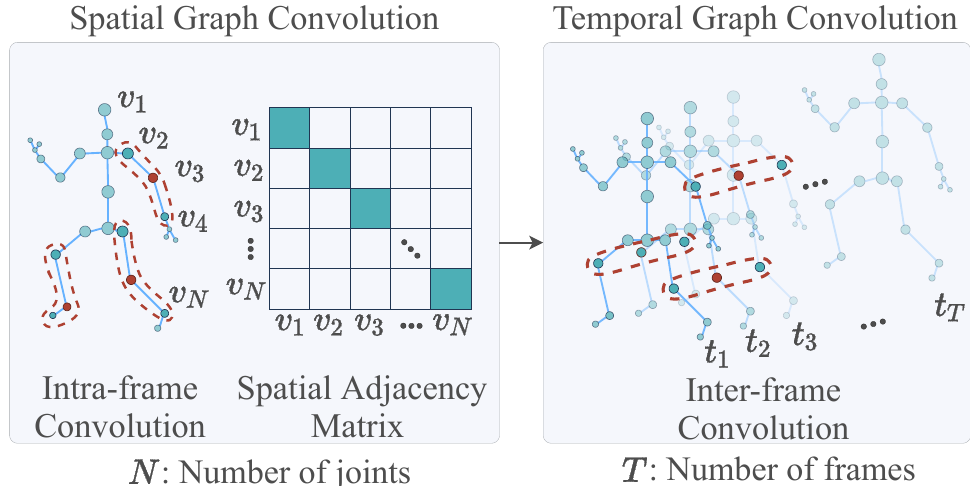
Figure 7. A spatiotemporal graph of a skeleton sequence. Light green dots represent the body joints (graph nodes). Light blue edges illustrate the intra-body edges. The spatial graph convolution receives as input a skeleton graph with its corresponding adjacency matrix to control the intra- frame (spatial) convolution (red dotted line) from the root node (red joint) neighbourhood. Then, 1-dimensional convolution is performed on the same positional joints across consecutive frames, resulting in the temporal (inter-frame) convolution.